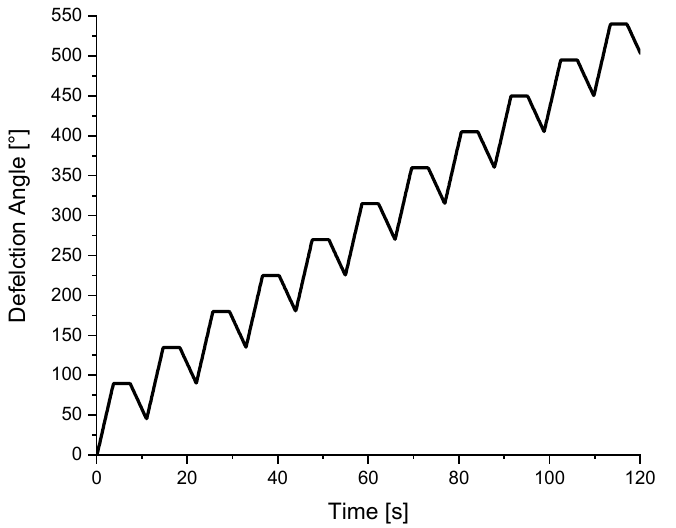
Figure 1. Increase in deflection for the kneading procedure with implemented relaxation phases.